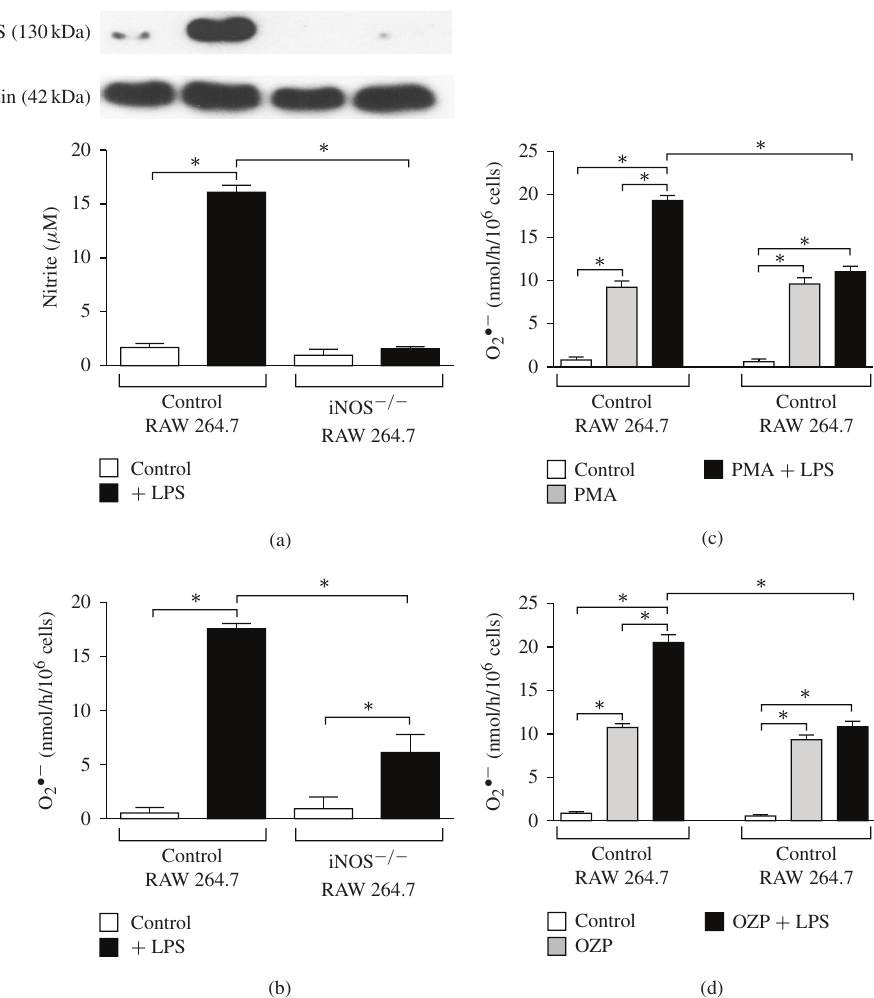
•− production in RAW 264.7 and iNOS − / − •−